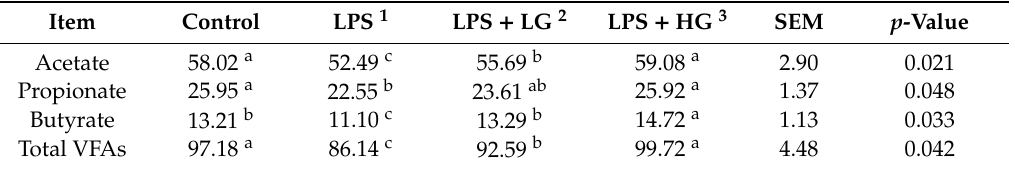
Table 10. Colonic volatile fatty acids (VFAs) concentrations of piglets fed di ff erent molecular weight β -glucan. (Unit: µ mol / g of dry